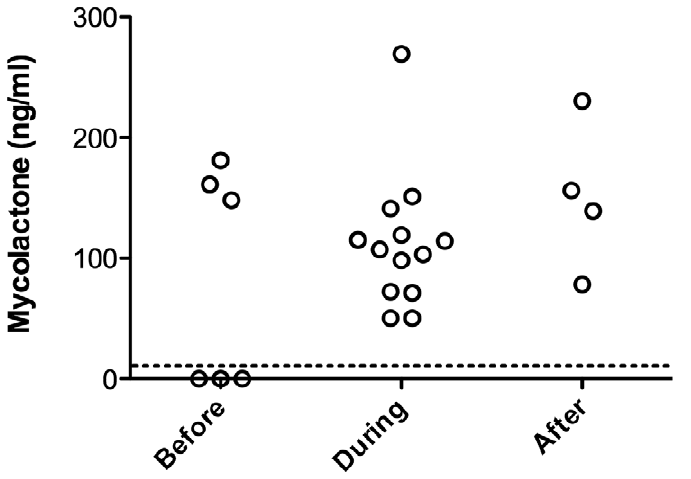
Figure 3. Mycolactone presence is maintained in ulcer exudates during antibiotic therapy. Mean concentration of mycolactone in ulcer exudates harvested before (0 week), during (2 to 8 weeks of treatment), or after completion of the 8 week antibiotic treatment. Dashed horizontal line indicates detection threshold.